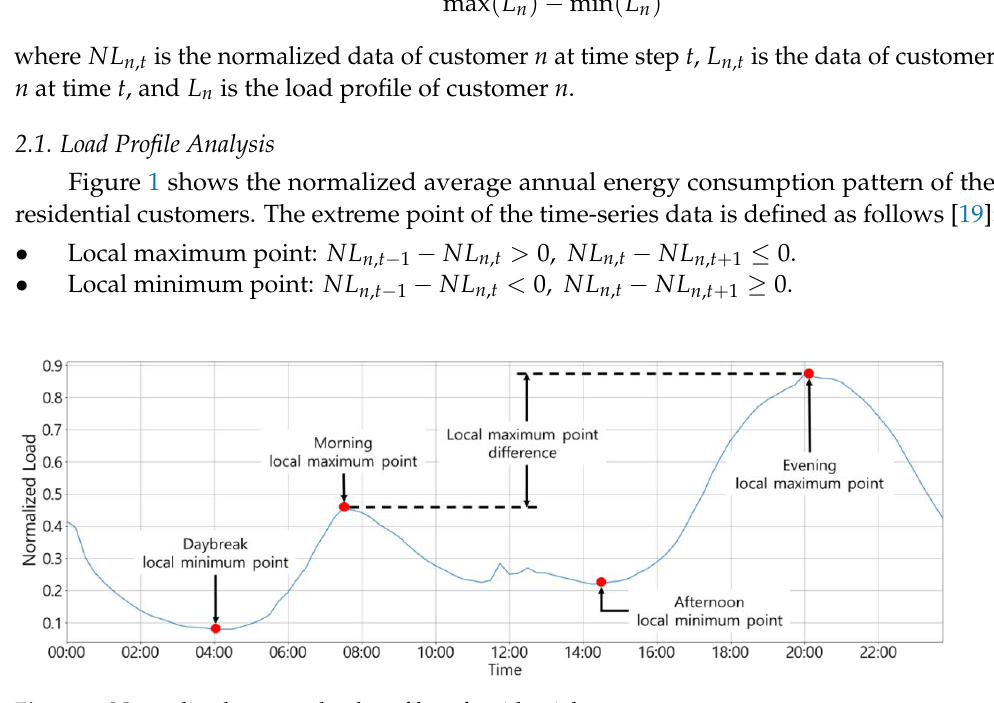
Figure 1. Normalized average load profiles of residential customers.